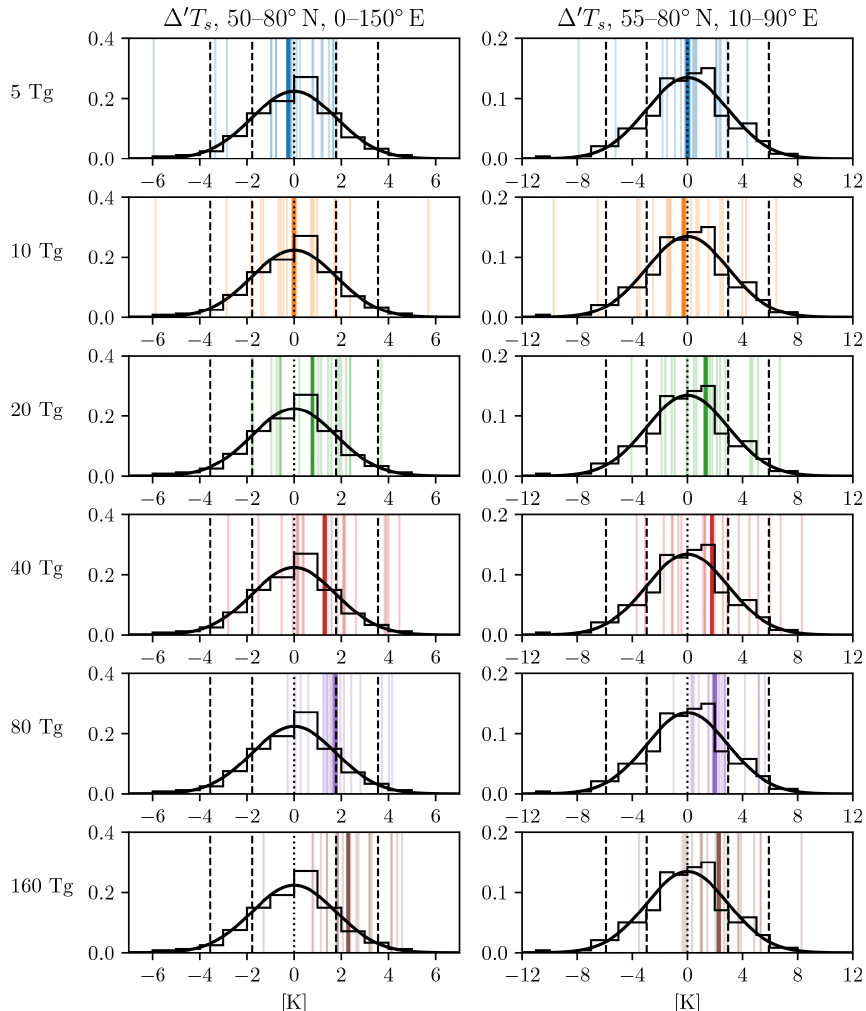
Figure 8. Eurasian winter surface temperature anomalies (computed with the difference-from-reference-period method), for each eruption (thin colored bars) and for the ensemble mean (thick colored bar), from 5 to 160Tg(S), top to bottom, as labeled. In each panel, these are superimposed on the climatology (black) of the same quantity from the pre-industrial control runs, quantified by a histogram and a Gaussian fit, and with dashed lines indicating the 1 σ and 2 σ ranges, as in Polvani and Camargo (2020). Left column: average temperature over the region 50–80 ◦ N and 0–150 ◦ E. Right column: average temperature over the region 55–80 ◦ N and 10–90 ◦